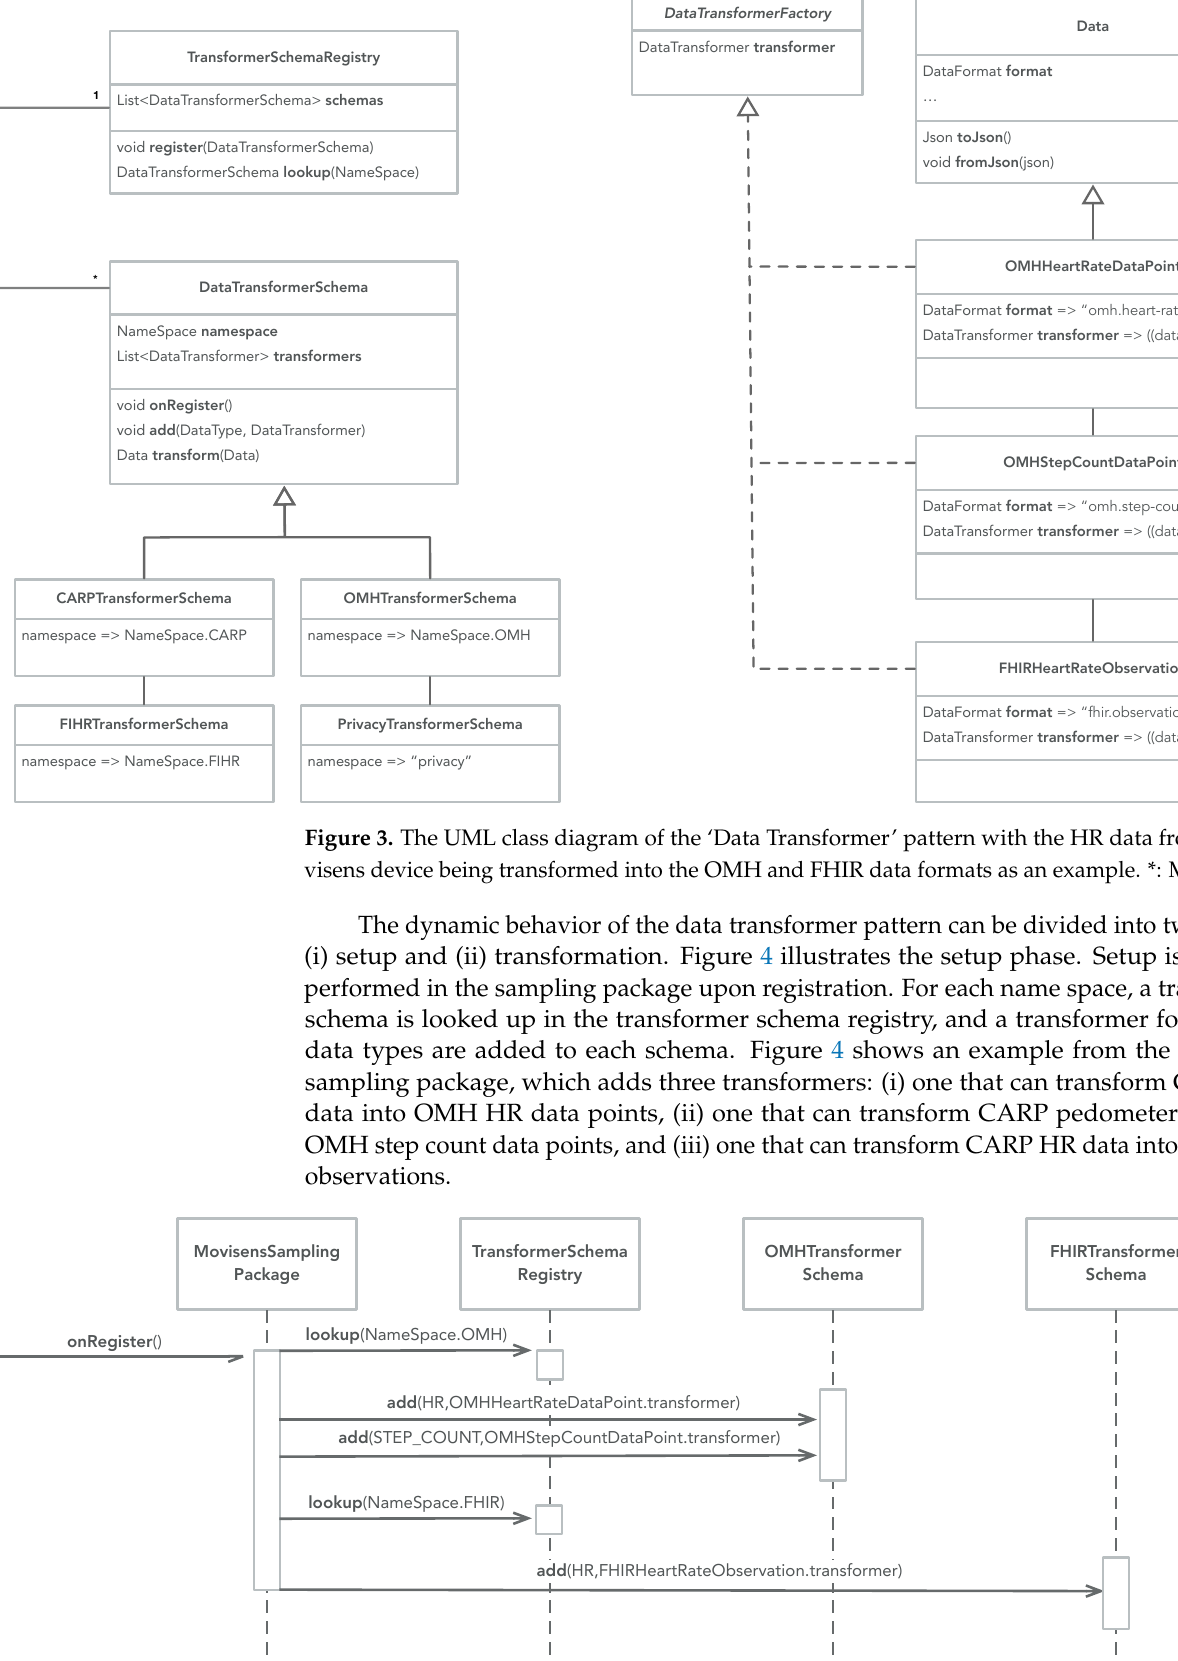
schemasTransformerSchemaRegistry List<DataTransformerSchema>